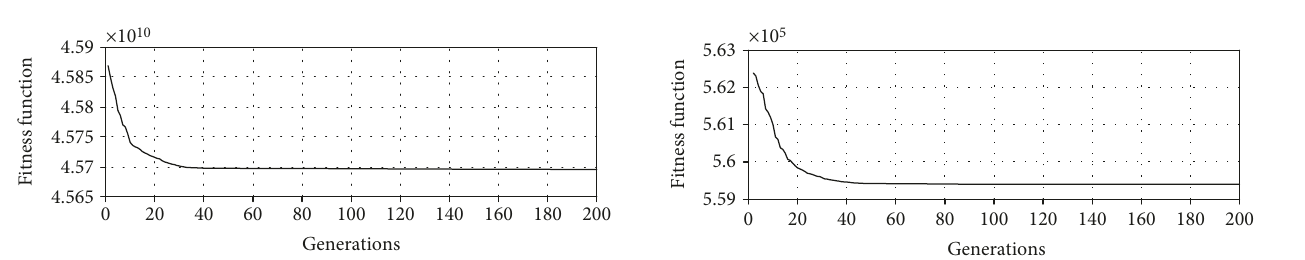
Figure 19: Evolution of the fi tness function of strategy 4 through generations.